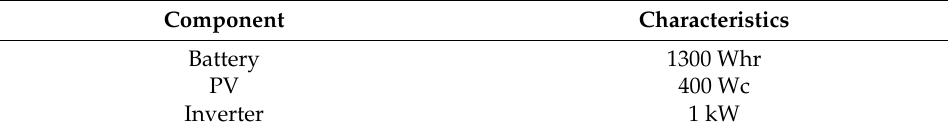
Figure 1. System configuration. Table 1. System characteristics.